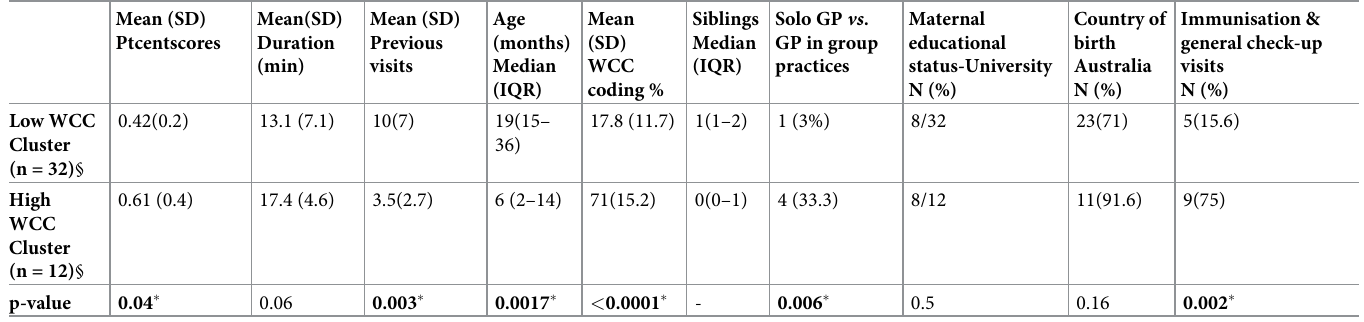
Table 5. Univariate analysis of demographic and practice level characteristics of GP visits according to